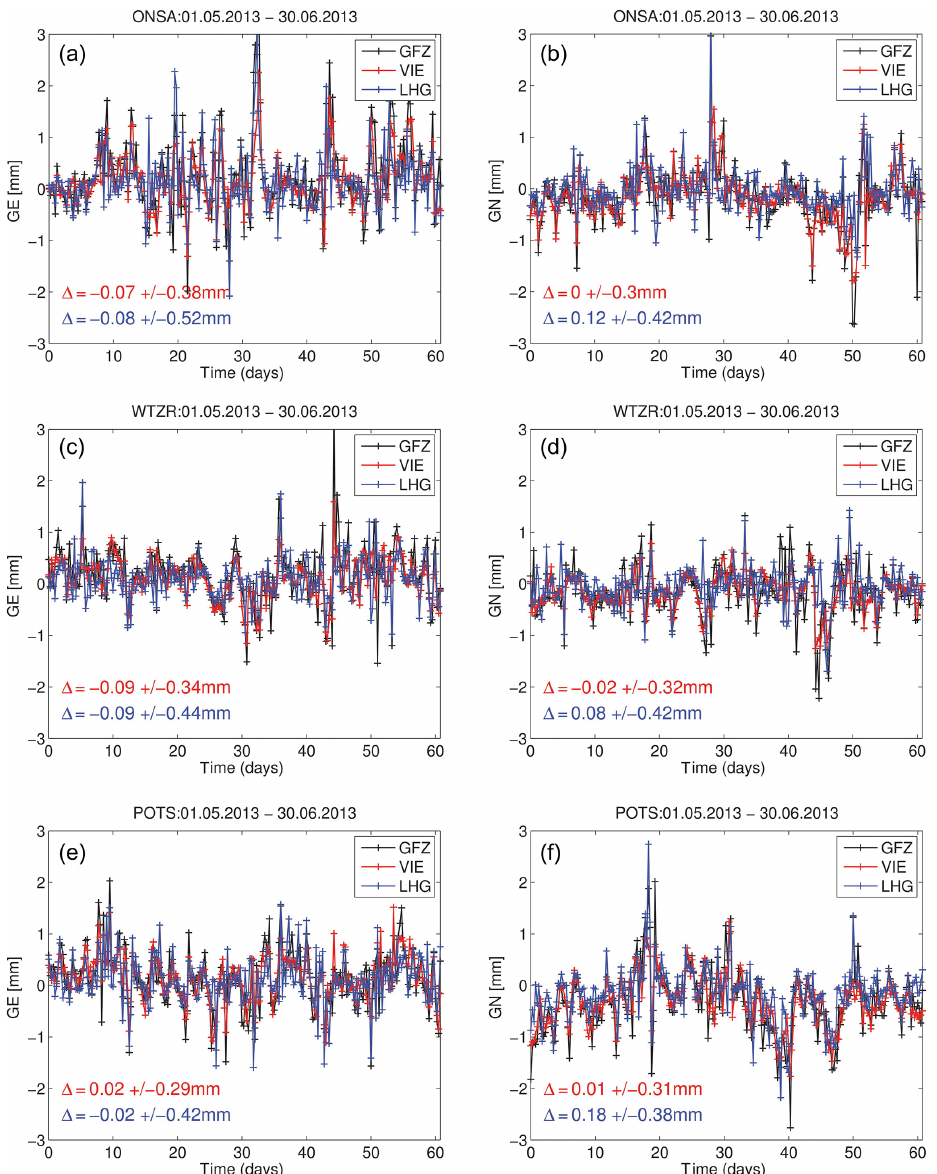
Figure B1. Panels (a) , (c) and (e) show the time series (1 May–30 June 2013) of the east-gradient component for stations ONSA, WTZR and POTS, respectively. Panels (b) , (d) and (f) show the time series of the north-gradient component for the same stations. The black line corresponds to the ERA5 tropospheric gradients (GFZ, regarded in the paper as NWM ERA5), the red line corresponds to the refined horizontal gradients provided by the TU Vienna (VIE) and the blue line corresponds to the so-called linearized horizontal gradients provided by the TU Vienna (LHGs). The red numbers represent the mean and standard deviation between VIE and GFZ. The blue numbers are the mean and standard deviation between LHG and